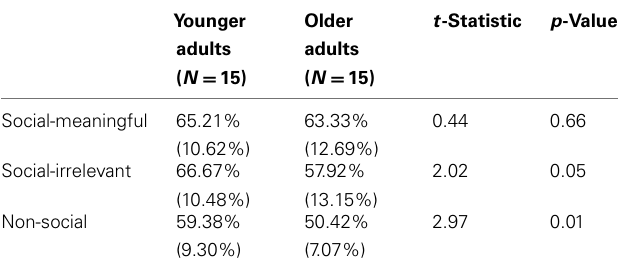
Table 1 | Retrieval test accuracy (M, SD) for each age group split by evaluation